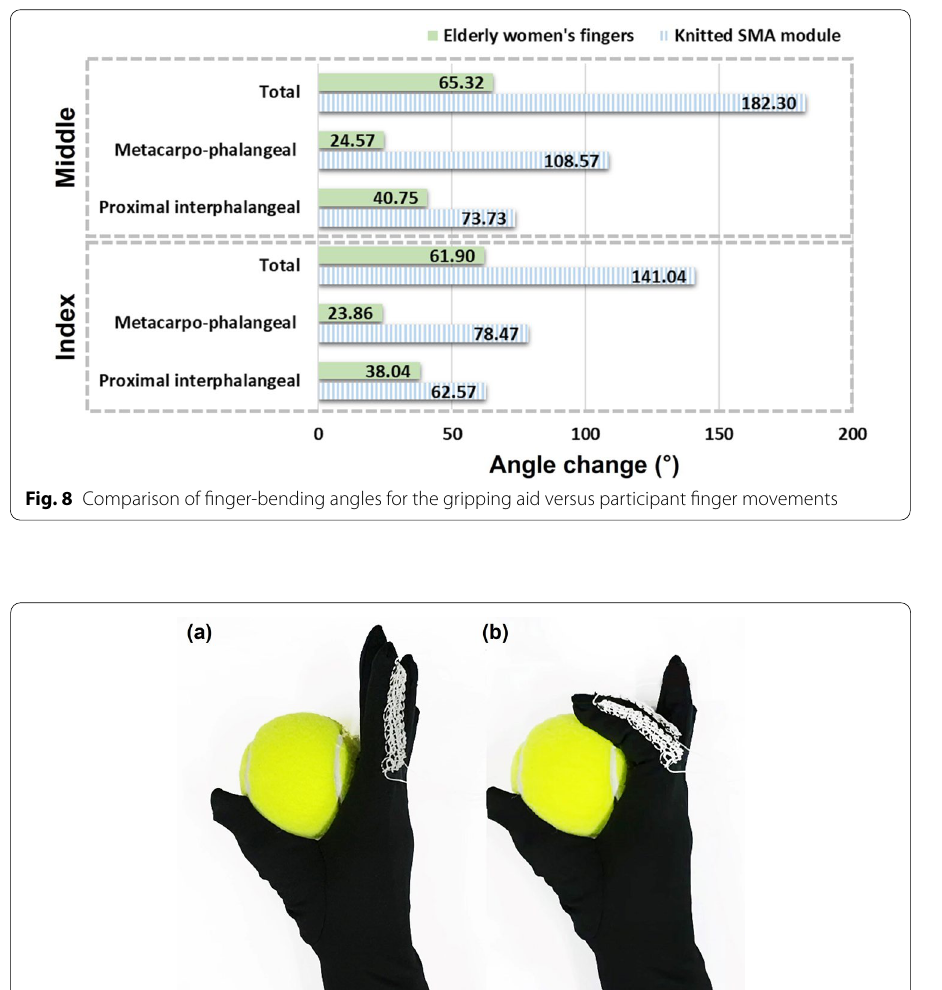
values of all multifold angles created by the bending of the two finger joints when holding an object; that is, the total bending angle of the index finger in participants and that of the gripping aid were equal to the second decimal point. The total bend- ing angle of the middle finger in participants and the gripping aid were 65.32° and 72.26°, respectively, with no significant difference (t 0.829, p 0.426). This indi- = − = cates that a gripping aid based on a knitted SMA can implement a motion similar to that of gripping by participants, which supported the study hypothesis. Furthermore,